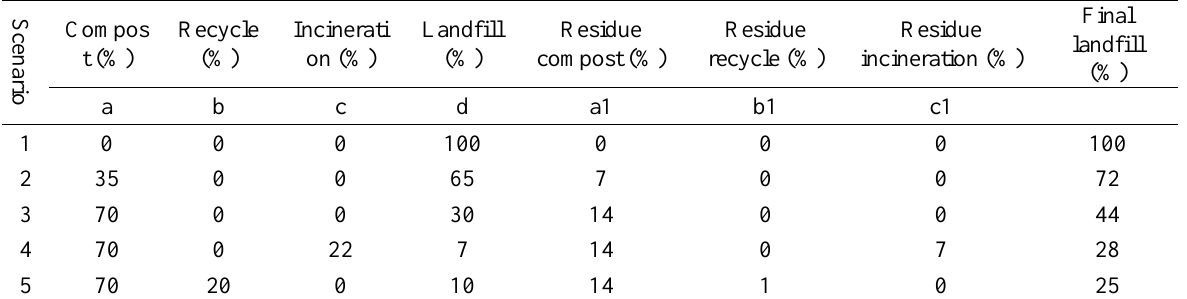
Figure 1. Flows of waste Table 2. Disposal solid waste